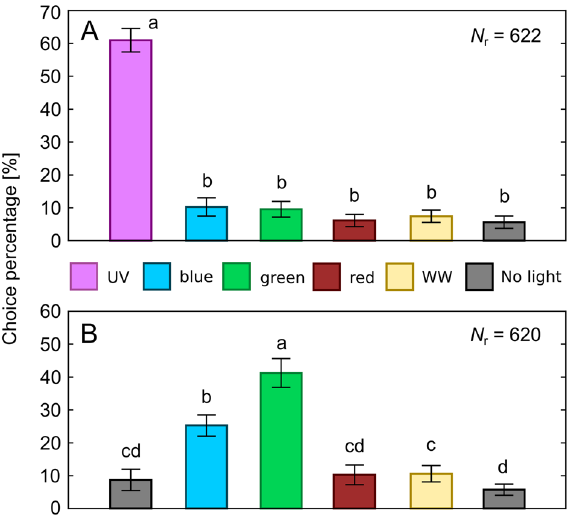
Figure 6. Choice percentages for the different chambers of the choice-box in trial types 1-2 in behavioural experiment 2. ( A ) Results for type 1 trials (Fig. 3A) with vertical bars denoting SD. Lowercase letters indicate statistically homogeneous groups at α = 0.05 significance level revealed by Tukey’s post-hoc test. N r is the number of respondent fungus gnat individuals out of the total number of 1000 tested specimens. ( B ) Same as A, for type 2 trials (Fig. 3B). Total number of trials was 20 in case of both type 1 and type 2 trials.